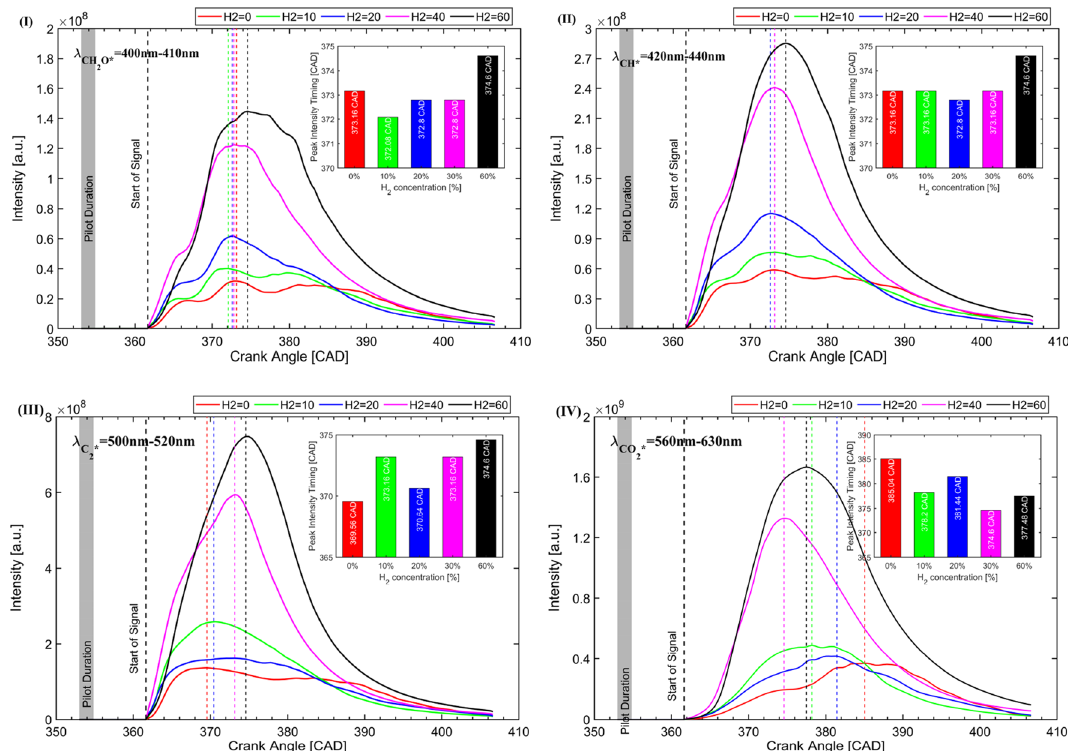
Figure 11. The evolution of the integrated CH 2 O*, CH*, C 2 * and CO 2 * chemiluminescence signal at different χ